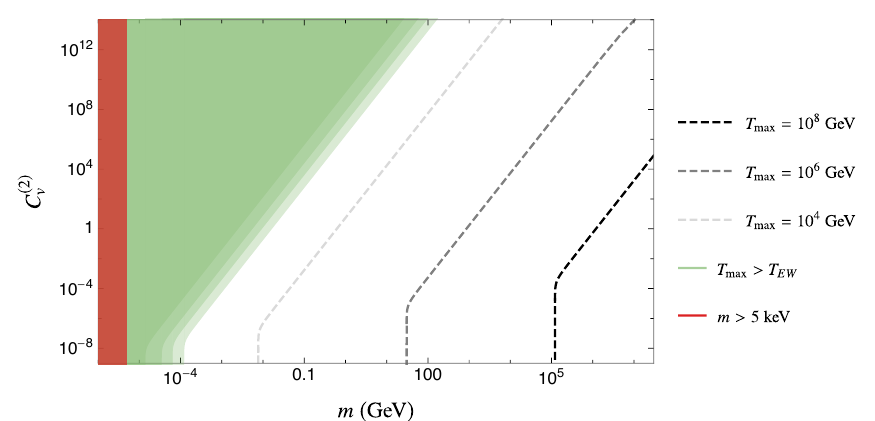
Figure 4: Contours of constant T leading to correct DM relic abundance as func- max tion of the DM mass m and the magnitude C ( 2 ) of the contact term in Eq. (25) for a v spin-2 DM particle in the gravity-mediated scenario. The red region is excluded by the small-structure bound m (cid:166) 5 keV. The green region corresponds to T below max the electroweak scale, contrary to the assumption used in our calculation. The right- bend of T contours marks the cross-over to the region where the contact term max contribution dominates over the purely gravitational